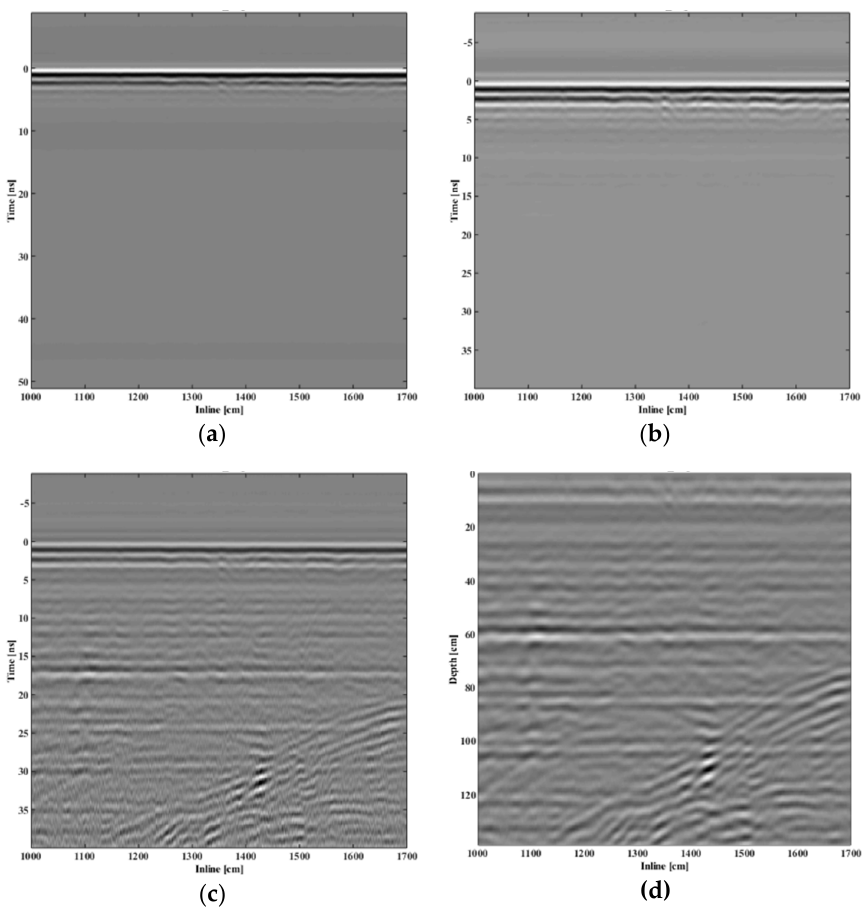
Figure 5. GPR data processing progression: ( a ) Time calibration; ( b ) frequency filtering; ( c ) amplitude equalization; and ( d ) time-to-depth conversion.